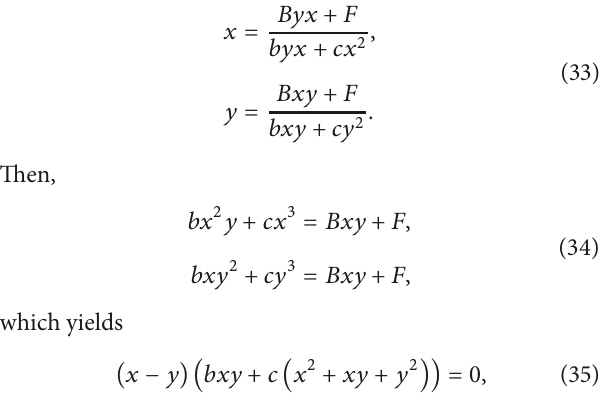
Figure 1: If 𝐹 < 𝐹 0 , then 𝑥 < 𝑥 𝑛ℎ , i.e., 𝑥 is LAS, and if 𝐹 > 𝐹 0 , then 𝑥 > 𝑥 𝑥 is 𝑛ℎ , i.e.,